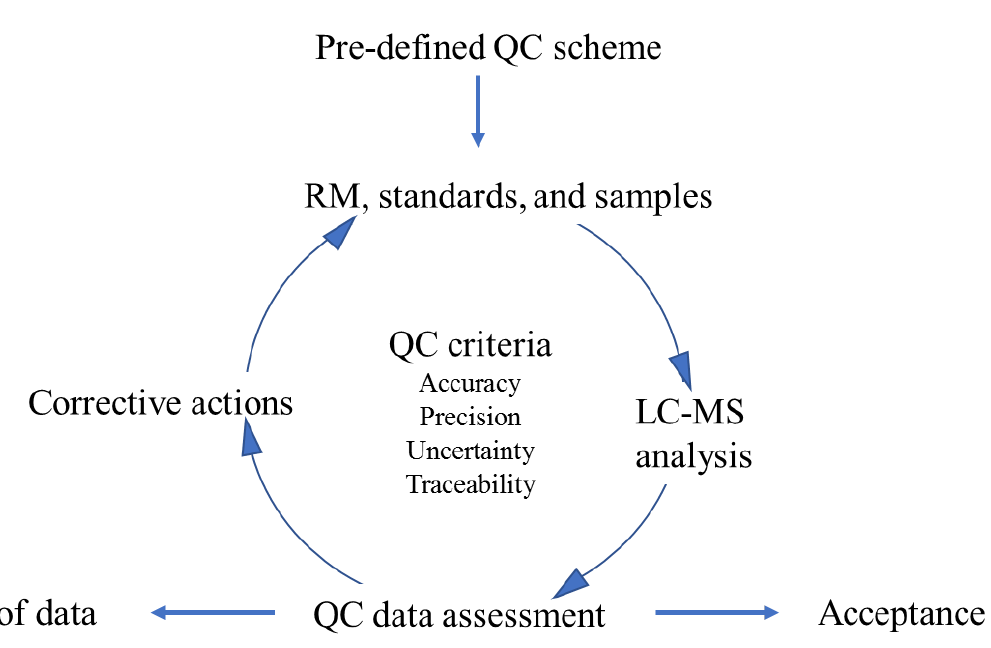
Figure 1. The role of QC samples in LC–MS-based mycotoxin analysis.